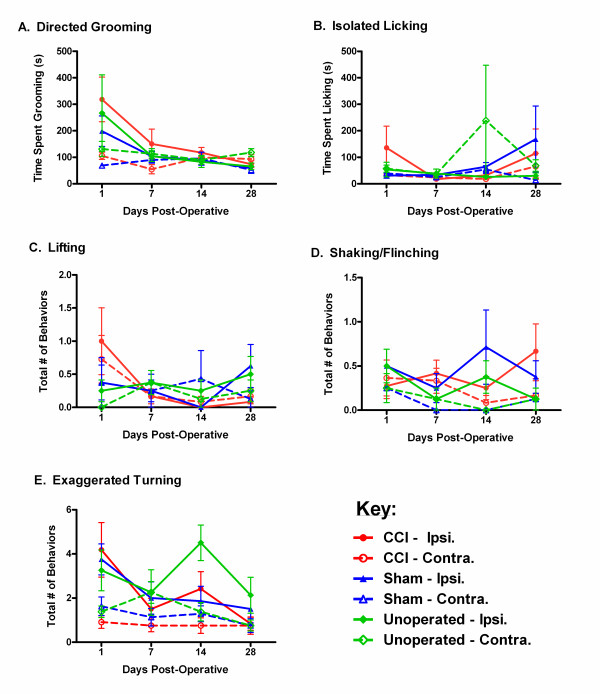
No evidence for asymmetrically directed behaviors in CCI mice. Symbols represent mean ± S.E.M. (A) directed grooming behavior (duration in s), (B) isolated licking behavior (duration in s), (C) hind paw lifting behavior (counts), (D) shaking/flinching behavior (counts), and (E) exaggerated turning behavior (counts) in 60 min of mice given CCI surgeries (red), sham surgeries (blue), or unoperated (green), and tested 1, 7, 14 and 28 days post-operatively. Closed symbols and solid lines (see key in bottom right) refer to the ipsilateral (Ipsi) side; open symbols and dashed lines refer to the contralateral (Contra) side. Definitions of all behaviors can be found in the main text; example video clips are available as Additional files 1, 2, 3, 4 and 5. Full videos are available upon request.